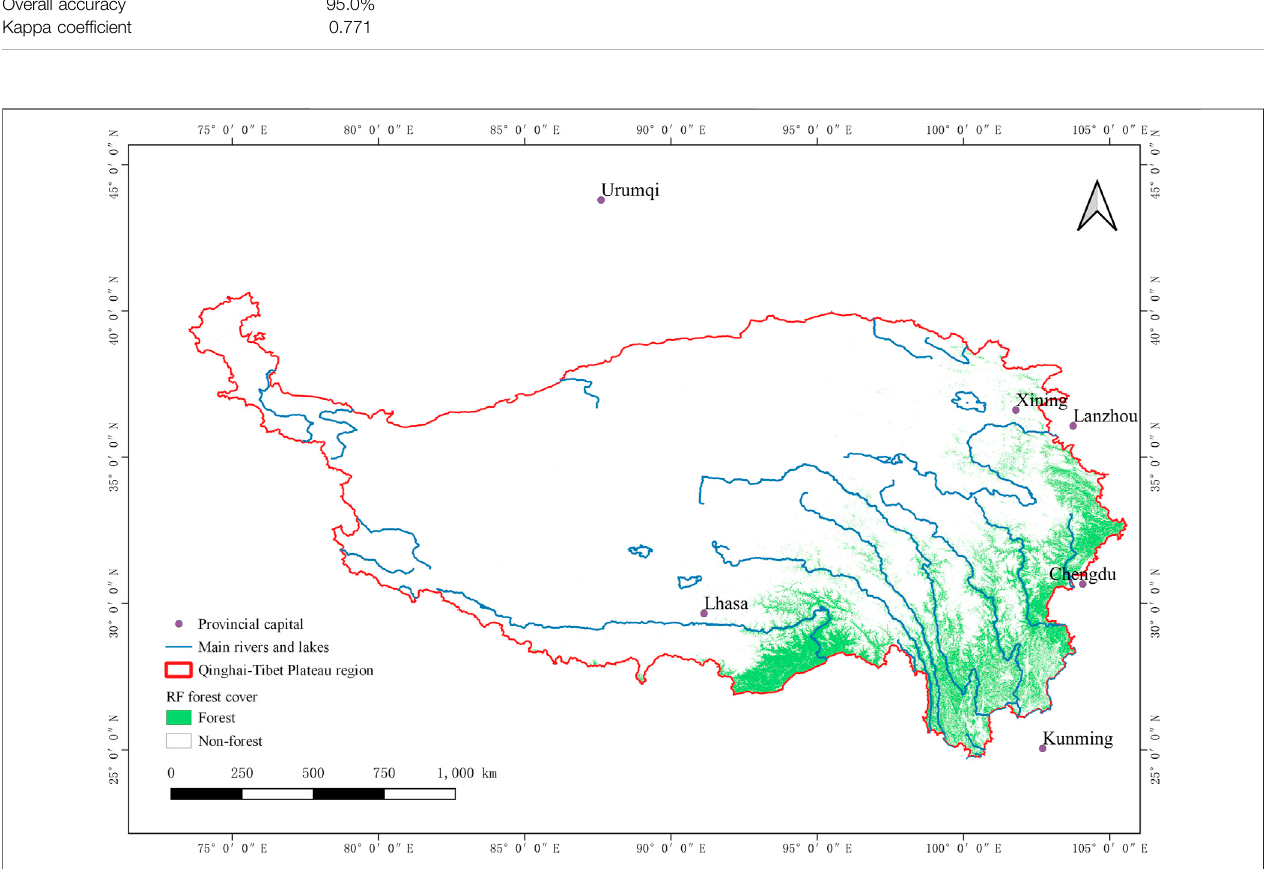
FIGURE 9 | Forest cover map for the QTP year